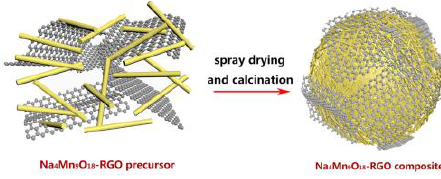
Figure 1. The schematic diagram of Na 4 Mn 9 O 18 -RGO composite by spray drying.